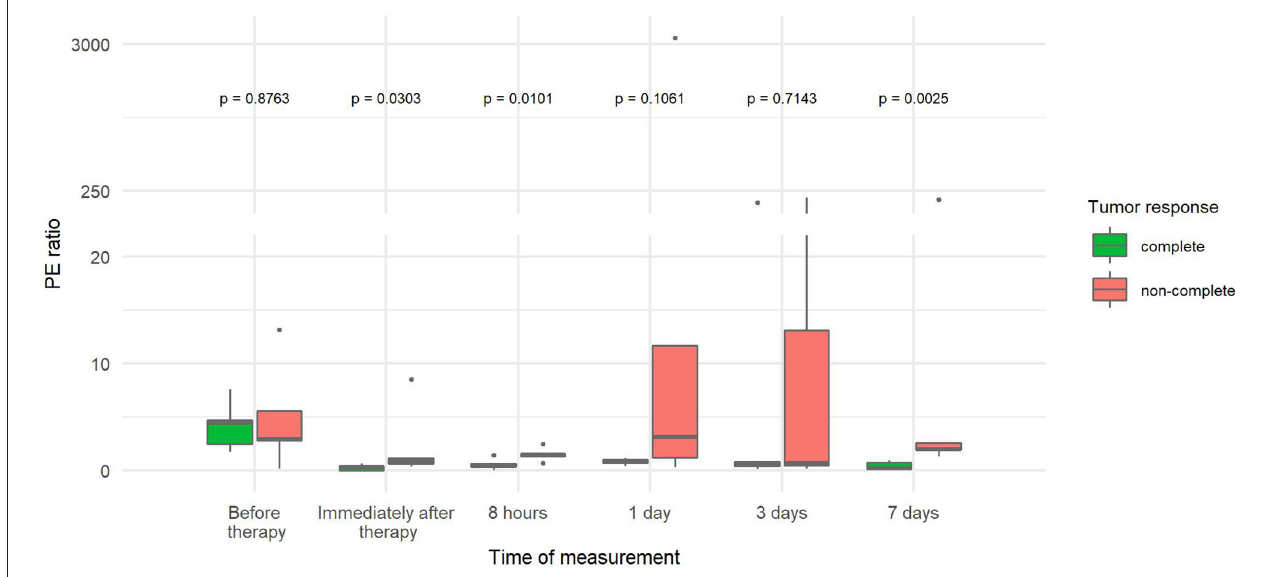
FIGURE 5 | Comparison of ratios between tumor peak enhancement and reference peak enhancement (PE ratio) at different time points between canine tumors with a complete and non-complete response to electrochemotherapy (ECT) with gene electrotransfer of plasmid DNA encoding interleukin IL-12 (GET pIL-12). Note the p -values presented at the top of the image. PE ratio is significantly lower for complete response tumors compared with non-complete response tumors immediately after therapy and at 8h and 7 days.